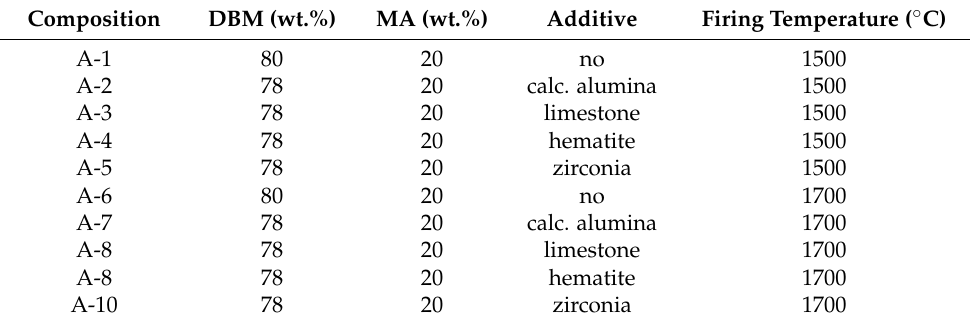
Table 1. Compositions of magnesia–spinel bricks produced at the